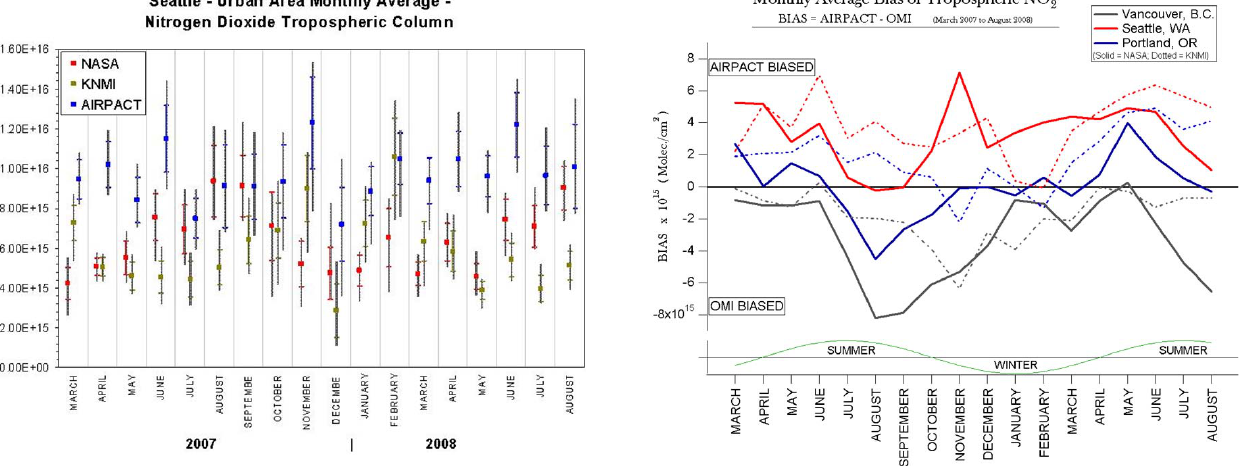
Fig. 11. Monthly average AIRPACT (spatially averaged) minus OMI, tropospheric NO 2 column biases in urban areas along the Interstate-5 Freeway from March 2007 to August 2008. Solid lines show NASA bias and dotted lines show KNMI bias. See Figs. 6, 8 and 10 for corresponding total tropospheric columns.